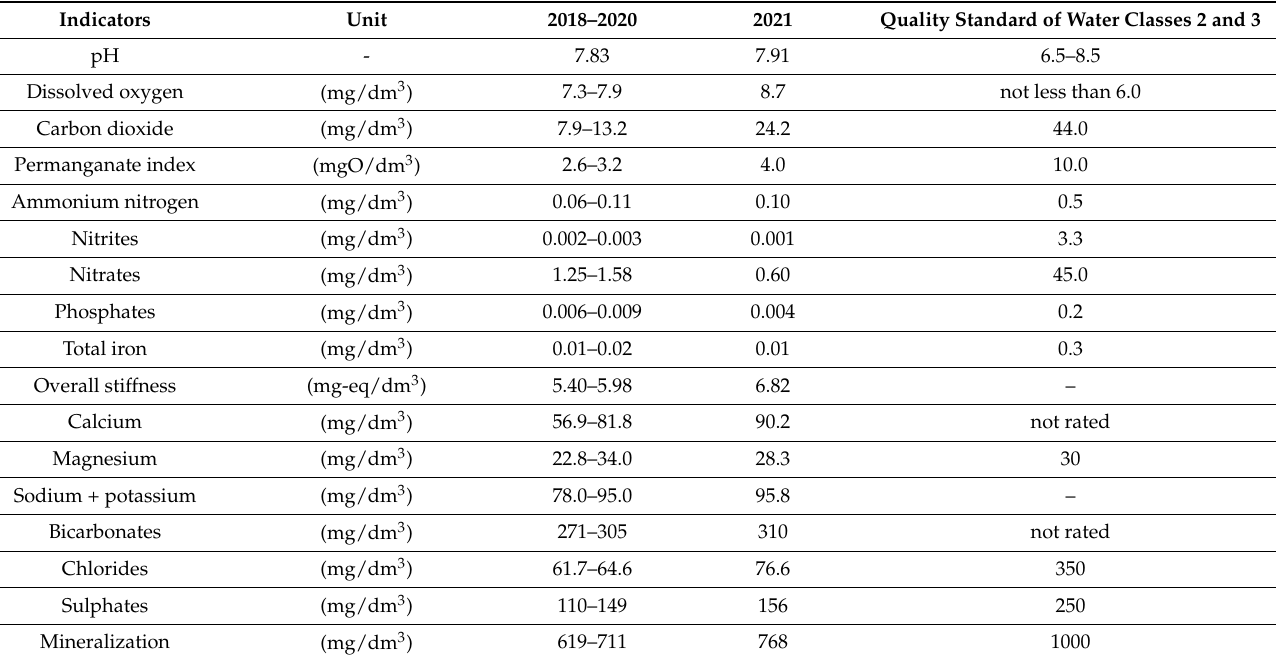
Table 1. Hydrochemical indicators of water of the Tokyrauyn River (average values).